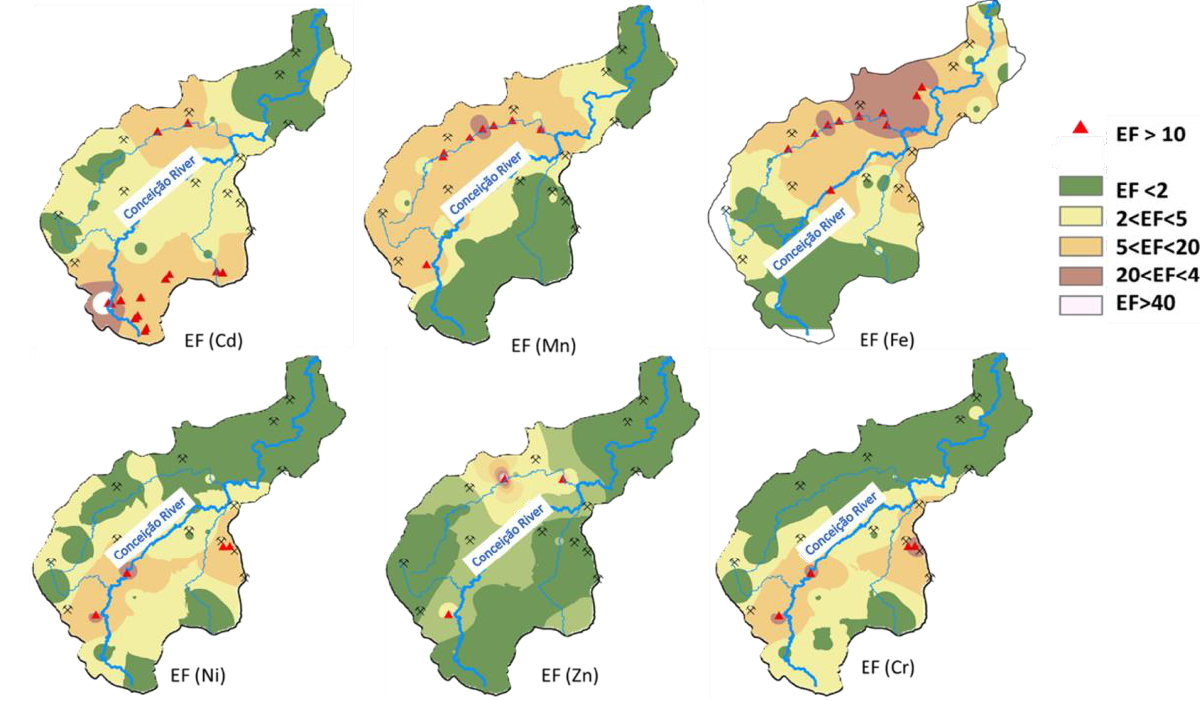
Figure 6. Spatial distribution of EF values in sediments of the Conceição river basin.